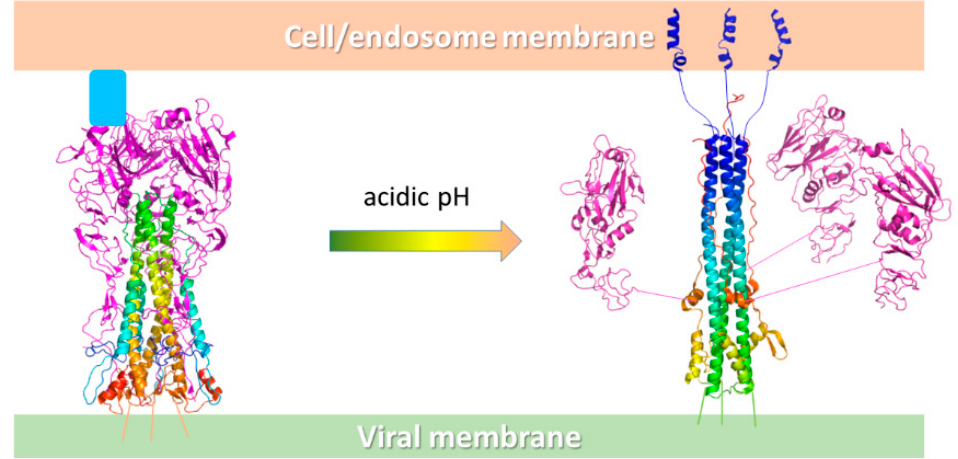
Figure 7. Schematic representation of the conformational change of HA at acidic pH. On the left, the HA exposed on the viral surface binds the host cell receptor sialic acids (pale blue box) on the HA 1 binding sites (purple cartoon), while the HA 2 trimer forms the central stem (rainbow cartoon). At acidic pH, the HA 2 portion undergoes a relevant conformational rearrangement with the fusion peptide (blue helices) that moves 100 Å away from the original position and inserts into the endosomal membrane. The process ends with the fusion of the viral and host membranes and the release of the viral material into the infected cell.